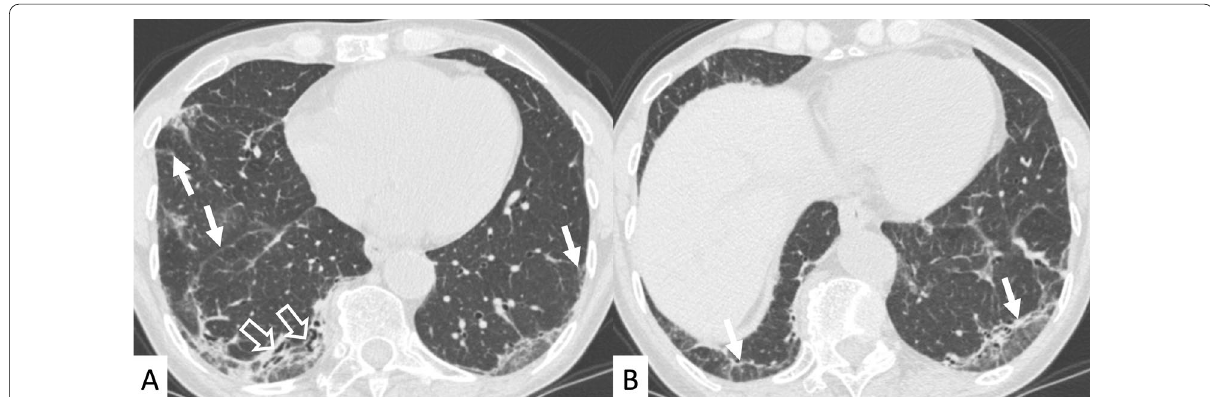
Fig. 18 OP and NSIP pattern in a clinical case of antisynthetase syndrome. Bronchiectasis are clearly seen in the dorsal region of the right lung (white empty arrows in A ); small linear opacities and lines (white arrows) are also appreciable in A . Subtle consolidations resembling a perilobular distribution are well depicted in B (white arrows)